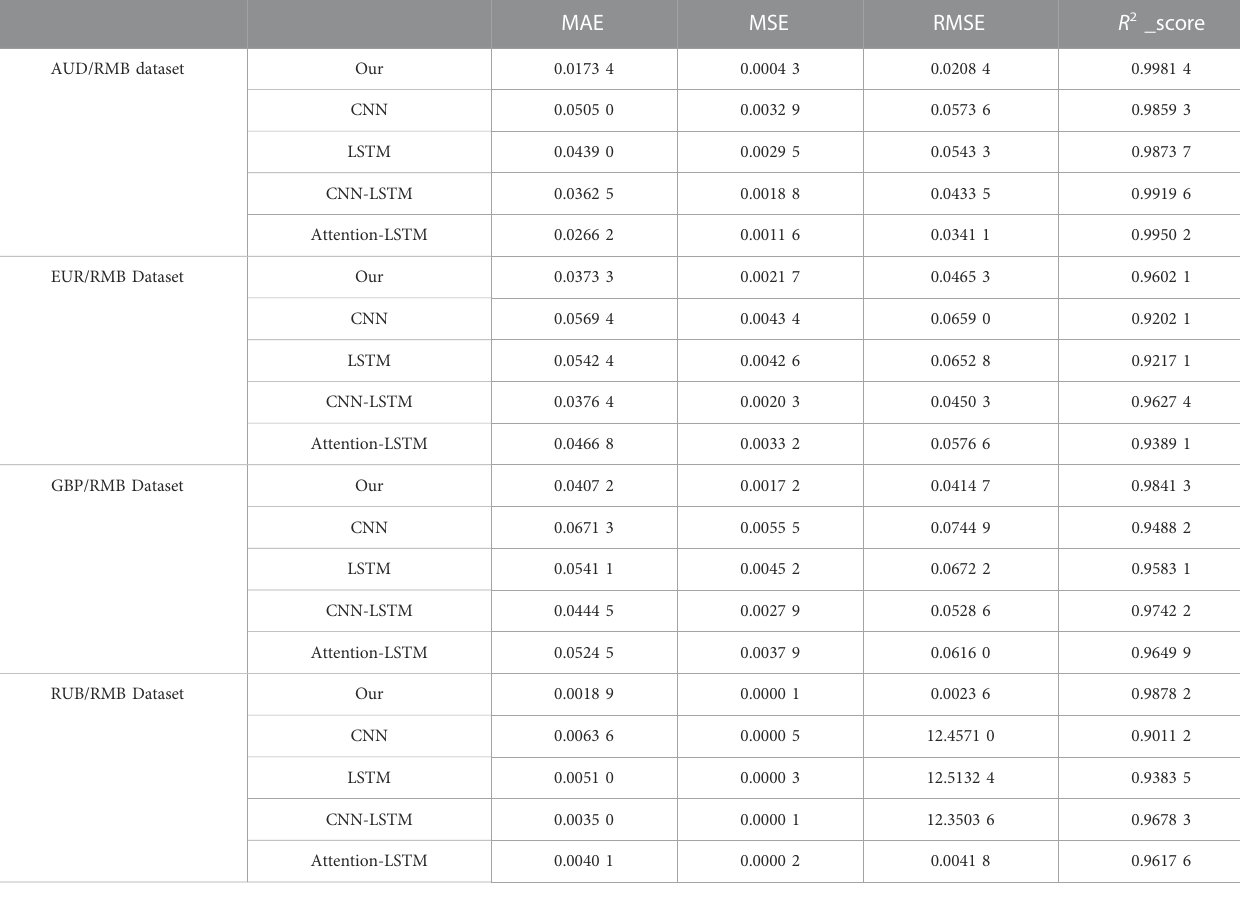
TABLE 1 Predictors of different comparison models.